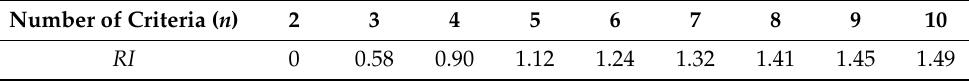
Table 1. Random index (RI) values for a discrete set of criteria n ≤ 10. Number of Criteria ( n